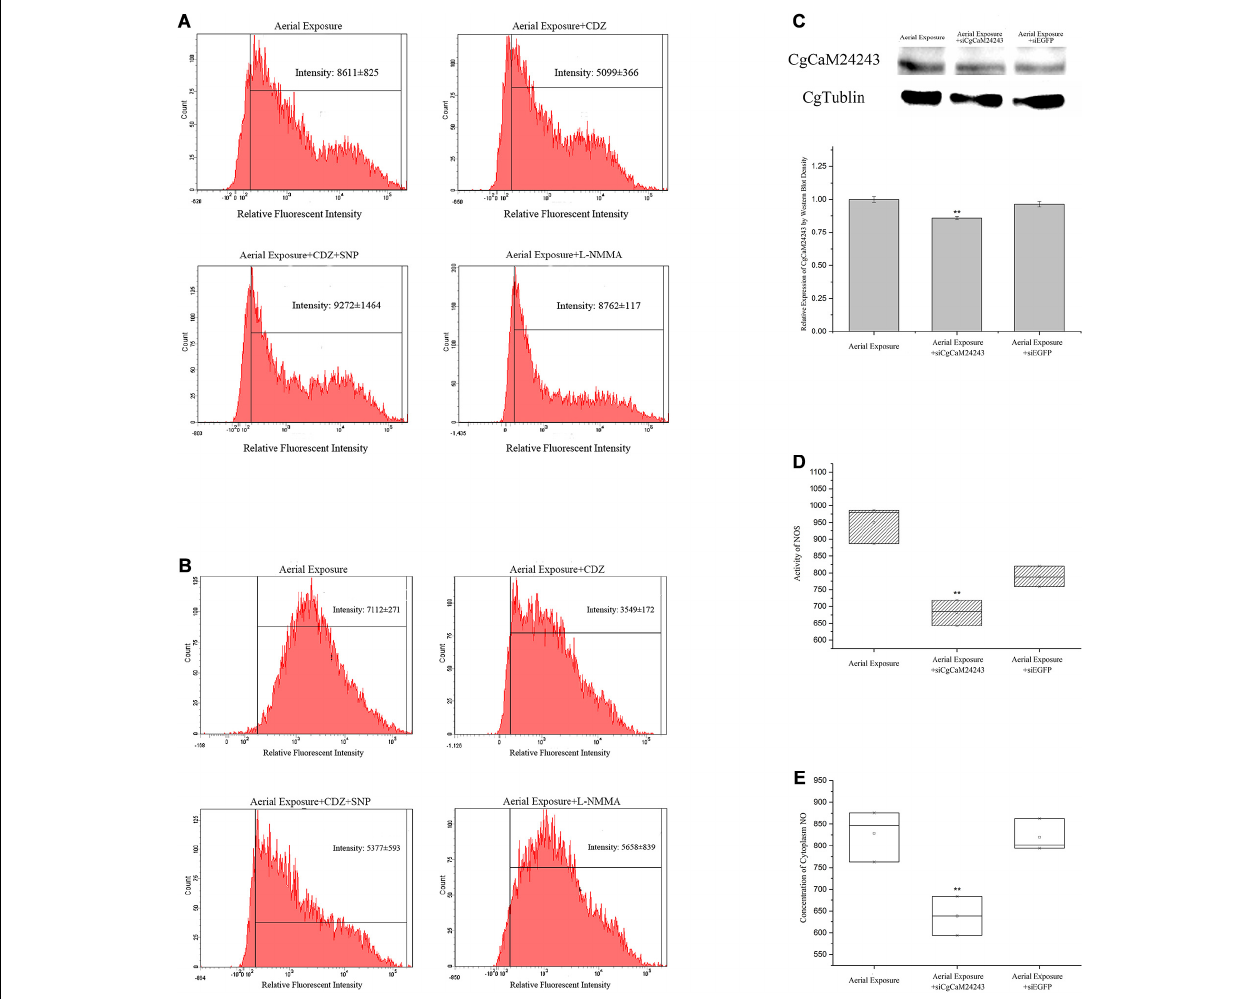
FIGURE 2 | Changes in oyster NOS/NO system after functional inhibition of CaMs and NOS. (A,B) Alternations of NOS activity and NO concentration inside hemocytes of oyster injected with CDZ (Calmidazolium chloride, CaM antagonist), CDZ+SNP (NO donor), or L-NMMA (NOS inhibitor) during a 2-day emersion. Significant decrease of NOS activity (A) and NO concentration (B) was observed in Aerial exposure+CDZ group where CaMs were suggested to be repressed by CDZ. The decrease in NO concentration was rescued in Aerial exposure+CDZ+SNP group where NO donor was provided. NO concentration also decreased in Aerial exposure+L-NMMA group where NOS activity was suppressed by L-NMMA. (C) Known-down of CgCaM24243 gene by dsRNA injection. Protein level of CgCaM24243 dropped significantly in oyster hemocytes after injection of dsRNA during the aerial exposure. Comparatively, CgCaM24243 protein remained unchanged in Aerial Exposure+siEGFP group where oysters were injected with dsRNA of pEGFP vector. A densitometric analysis was conducted to facilitate the significance determination. (D,E) NOS activity and NO concentration after the in vivo known-down of CgCaM24243 gene. Both the NOS activity (D) and NO concentration (E) in hemocytes were found significantly decreased in Aerial Exposure+siCgCaM24243 group where dsRNA of CgCaM24243 was injected during emersion. Aerial Exposure+siEGFP group was used as negative control. Significance was determined by one-way analysis of variance (ANOVA) and marked with ** if p <